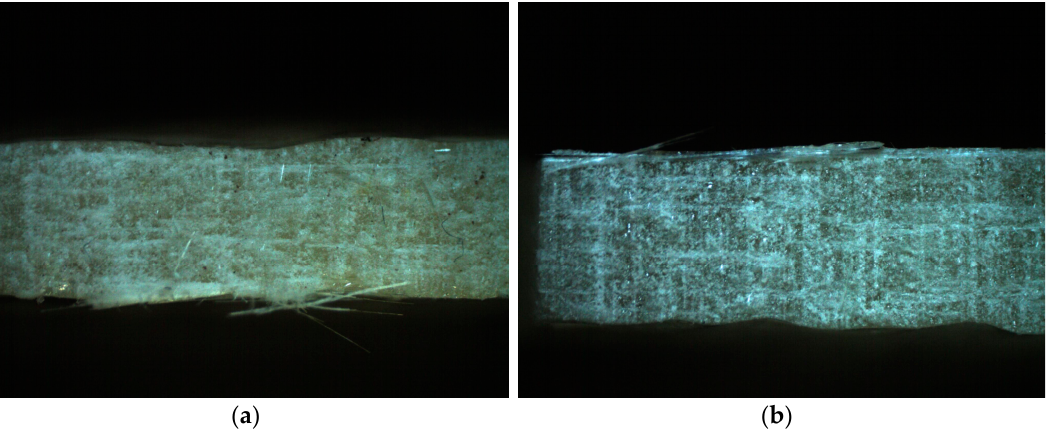
Figure 5. Some examples of the worn composite surfaces with the polymer matrices MC-DUR 1200VK and the particulate filler proportions of 10 wt.%: ( a ) with the emulsion binder; ( b ) with the powder binder.